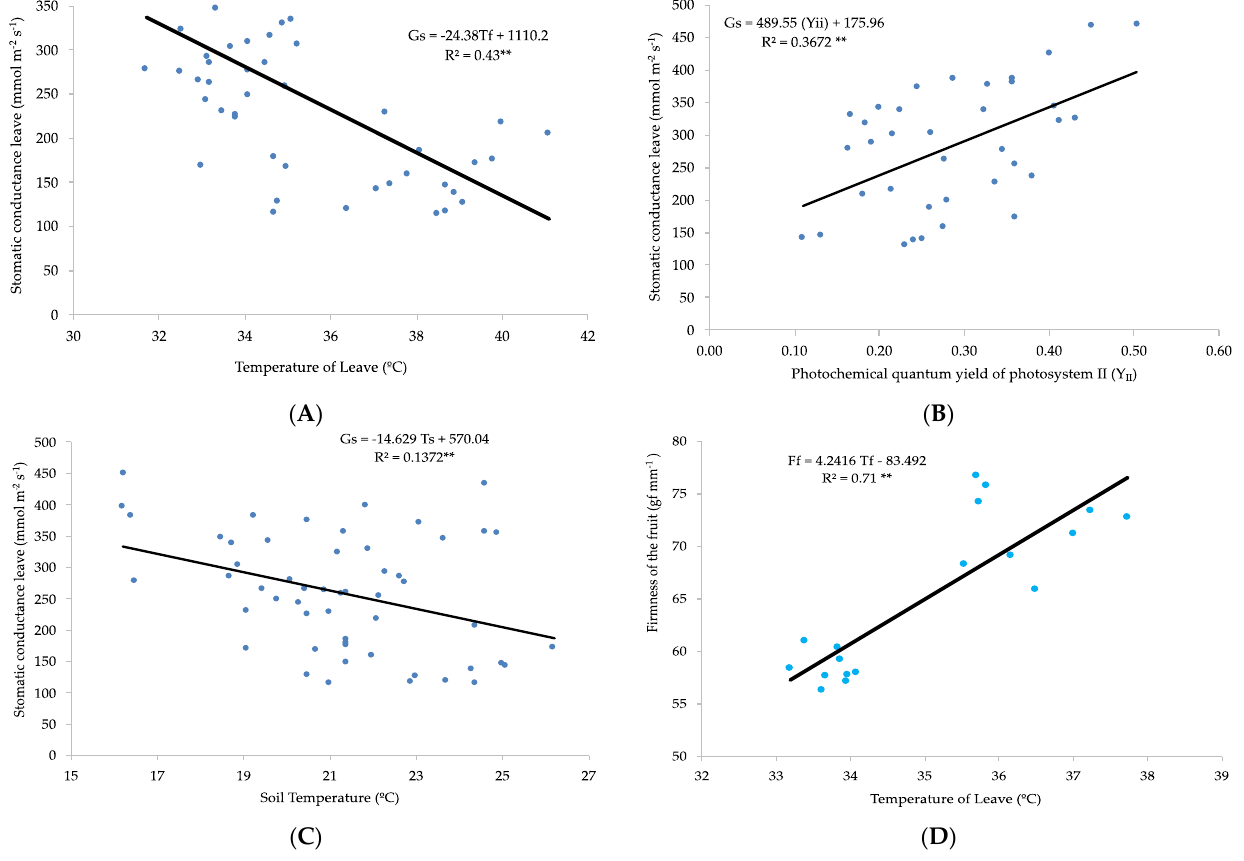
Figure 2. Correlation of stomatal conductance (gs) in different blueberries cultivars grown with different mulches, ( A ) temperature of leaves (°C), ( B ) soil temperature, ( C ) photochemical quantum yield of photosystem II (Y II ) and ( D ) firmness of fruit and temperature of leaves. ** Significant at p < 0.001.